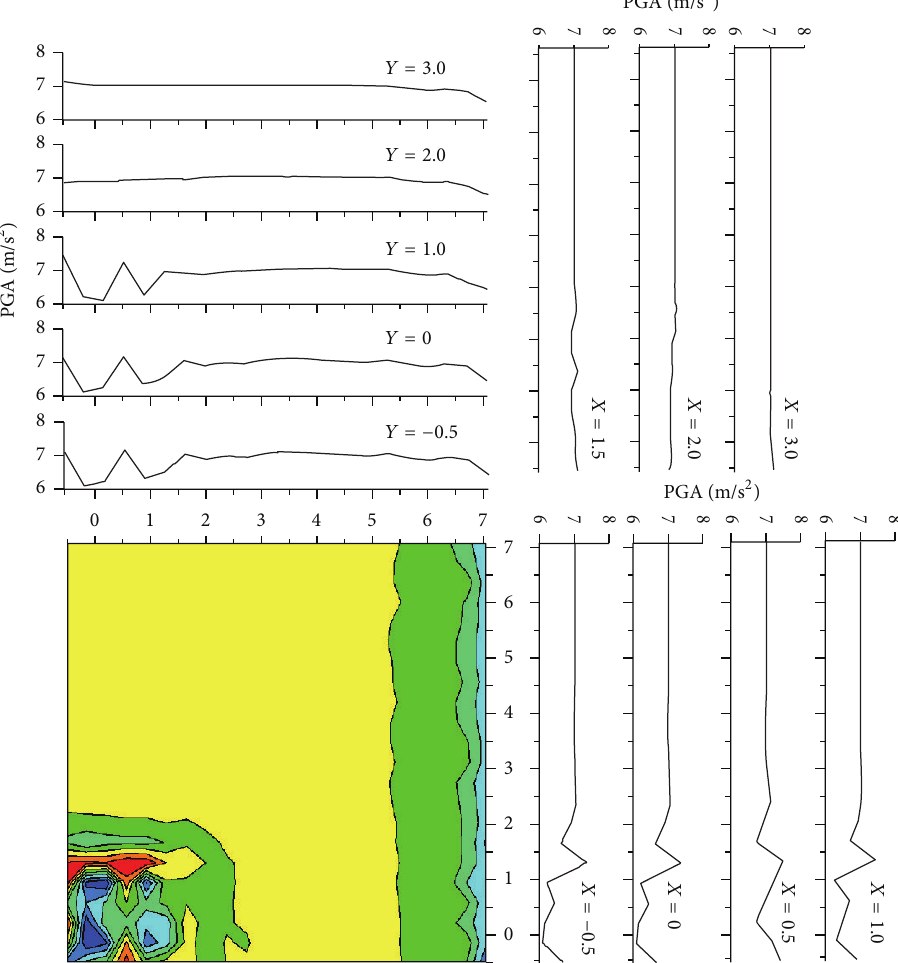
Figure 21: Peak ground acceleration distribution of URBAN4-4 with respect to nondimensional spatial coordinates (1/4 FE model, 𝐷 = 1.25 , El Centro, 𝑆𝑋 . The structure location is (0, 0) , (0, 1) , (1, 0) , and (1,1) . The urban nondimensional width is 4.0; the nondimensional effective width of the structural group parallel to the excitation is 7.0; the nondimensional effective width of the structural group perpendicular to the excitation is